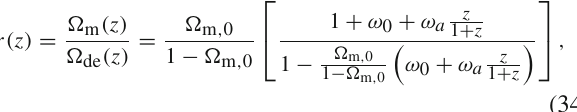
Lagrange multiplier and as can be seen in Eq. (32), the dark energy sector is related with the potential of the mimetic field. On the other hand, from Eqs. (28), (29) and (30), the parameter state of the dark energy component can be penned as